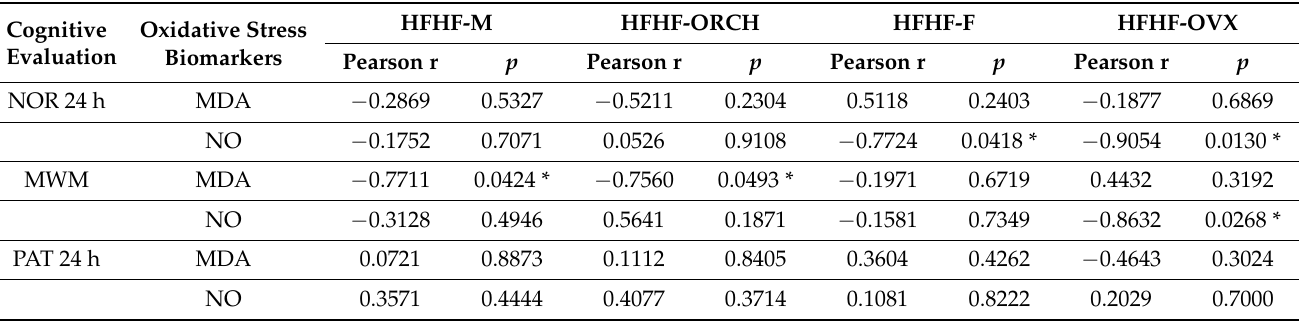
Table 1. Results of the Pearson correlation between the concentration of MDA and NO with the results of 24 h NOR, MWM, and